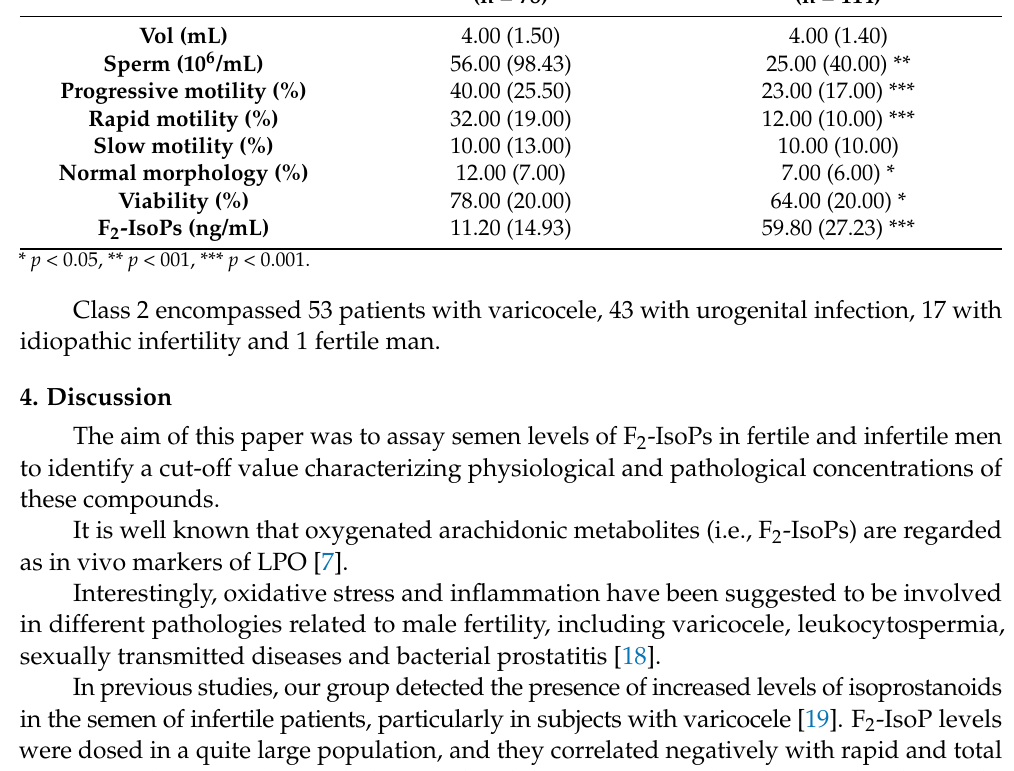
Table 3. Median (IQR) of semen variables of the considered subjects grouped following J value calculated for F 2 -IsoP level.